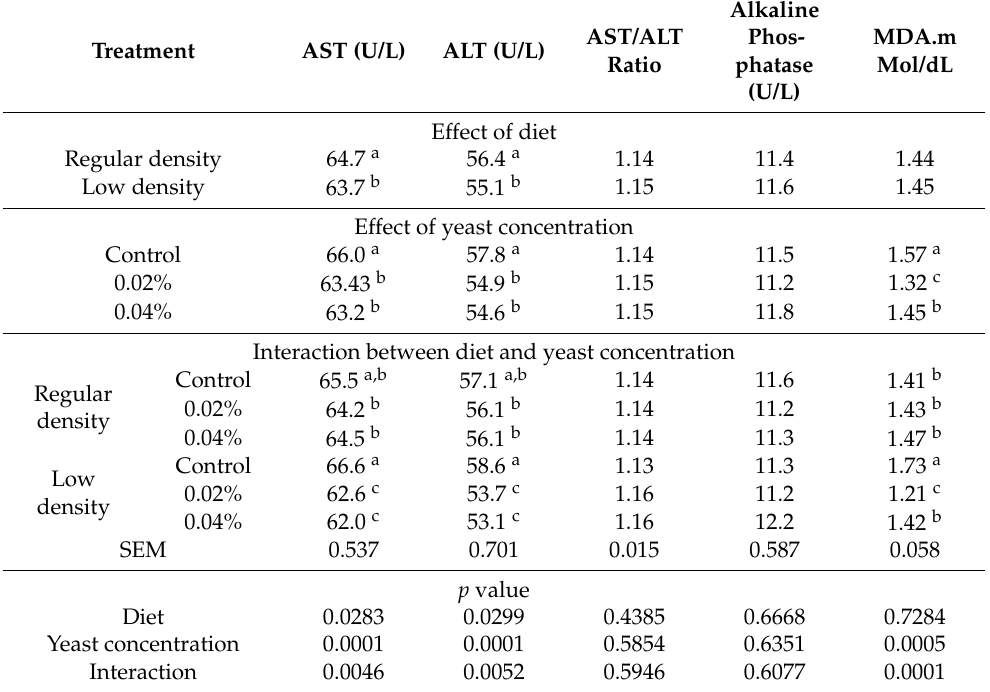
Table 3. Impact of different concentrations of Saccharomyces cerevisiae on liver enzymes and